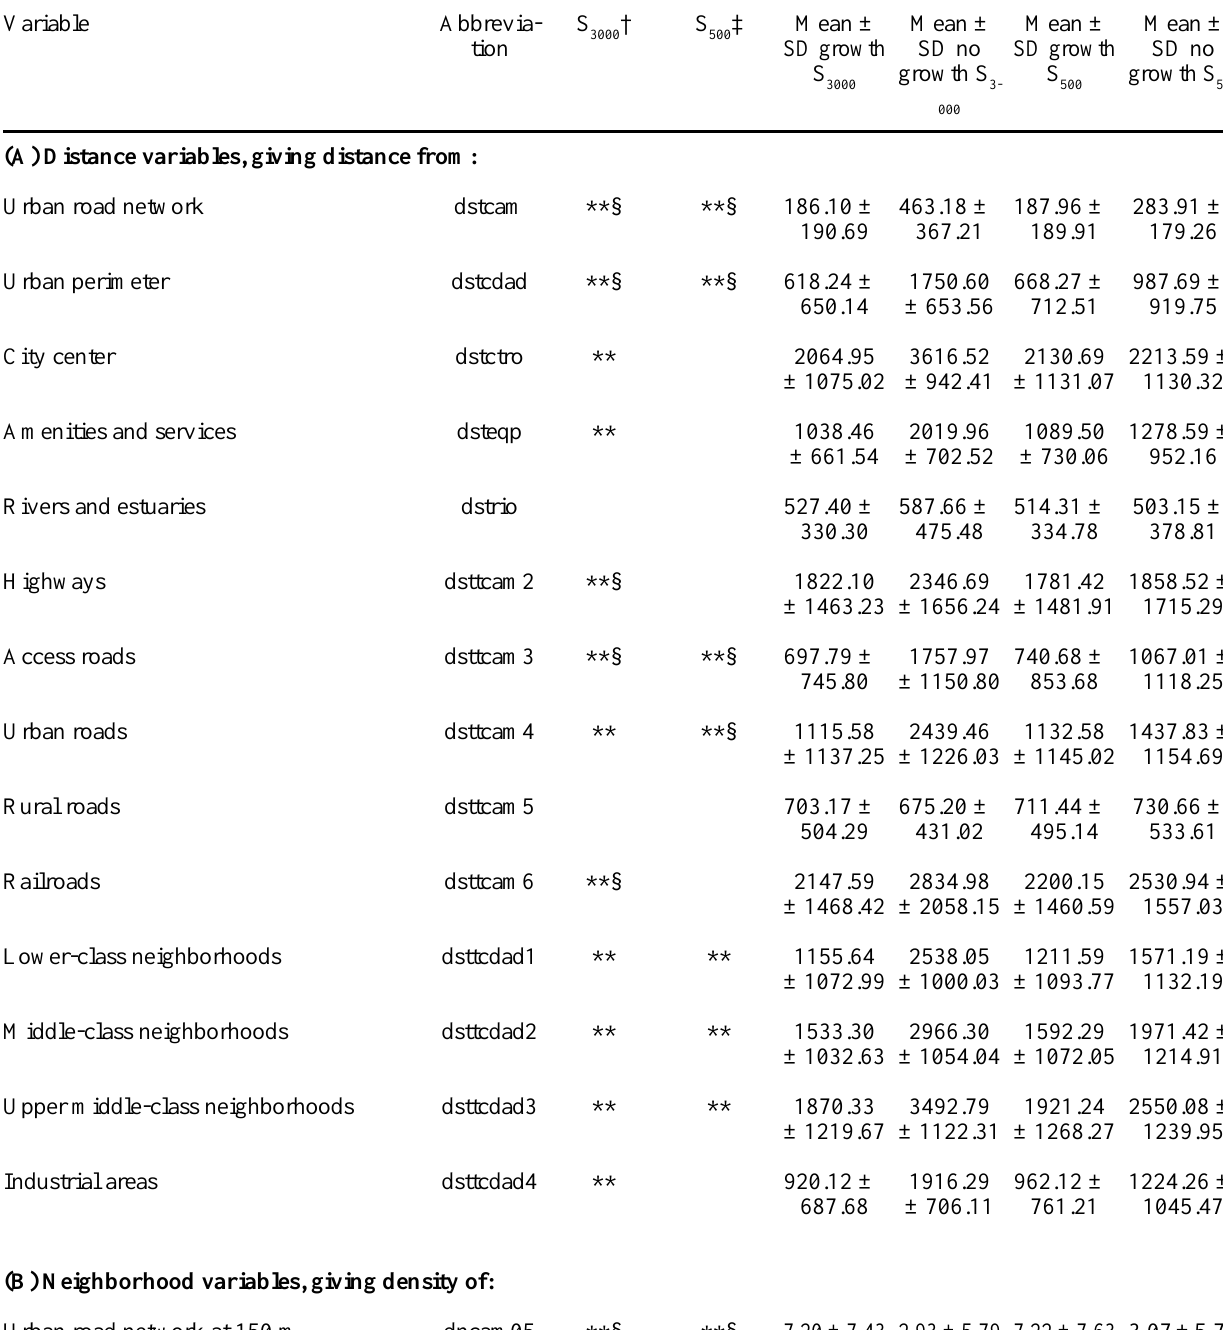
Table 1. Derived variables considered in the statistical analysis and their mean values in cells with growth and no growth of the independent variable (see Fig.